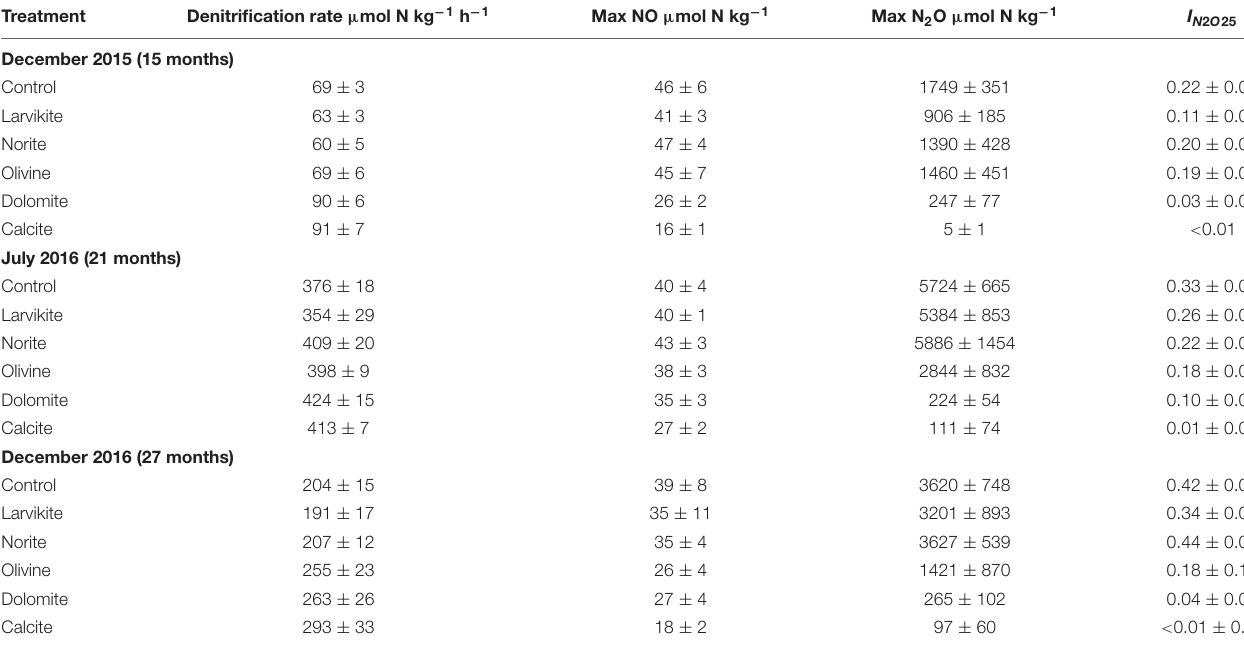
TABLE 2 | Denitrification rates and transient NO and N 2 O accumulation in anoxic slurry incubations.